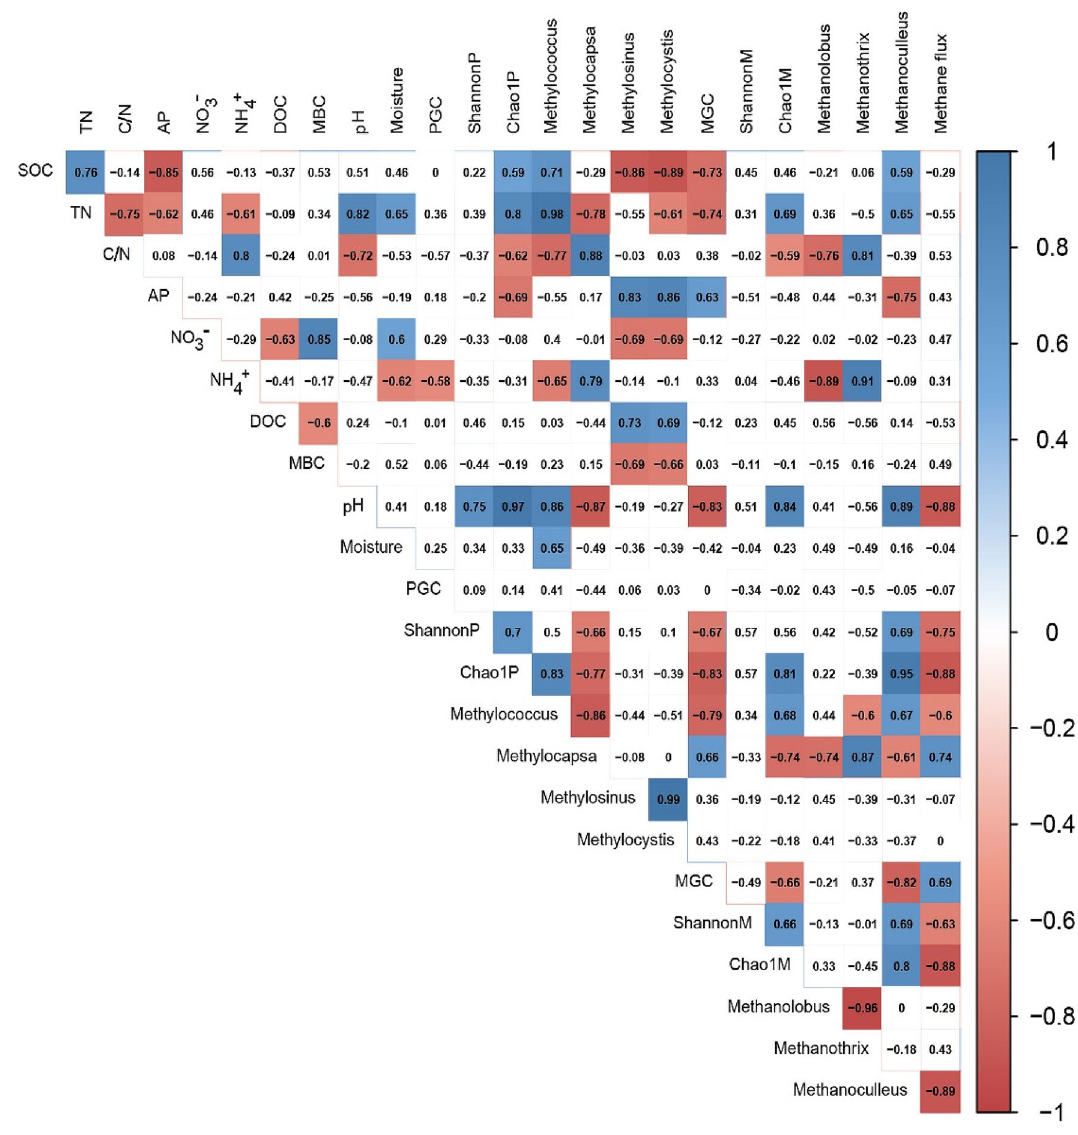
the Shannon index only decreased significantly in the N60 treatment ( P < 0.05). The Shannon and Chao1 indexes for methanotrophs were positively correlated with soil pH ( P < 0.05). In addition, the Chao1 index for metha- notrophs was negatively correlated with AP concentration ( P < 0.05) and the C/N ratio ( P < 0.05) but positively correlated with SOC ( P < 0.05) and TN ( P < 0.05; Fig. 2) concentration. Pearson’s correlation analysis revealed that the Chao1 index for methanogens was positively correlated with soil pH ( P < 0.05) and TN concentration ( P < 0.05) but negatively correlated with the C/N ratio ( P < 0.05). Methanotroph and methanogen community structure. The number of operational taxonomic units (OTUs) detected varied across the N addition treatments (Fig. S1). The pmoA OTUs ranged from 231 in the N90 treatment to 349 in the control treatment. For mcrA , a total of 1050 OTUs were detected in the control treatment; in the N30, N60, and N90 treatments, 898, 867, and 1157 OTUs were detected, respectively. When